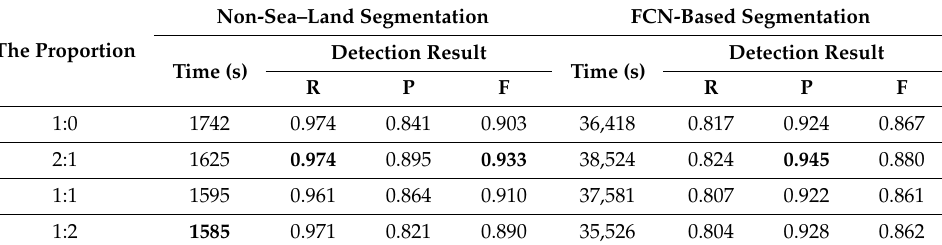
Table 9. Results and time spent of detection of the second JL-1 image. Table 5. Results and time spent of detection of the GF-1 image.